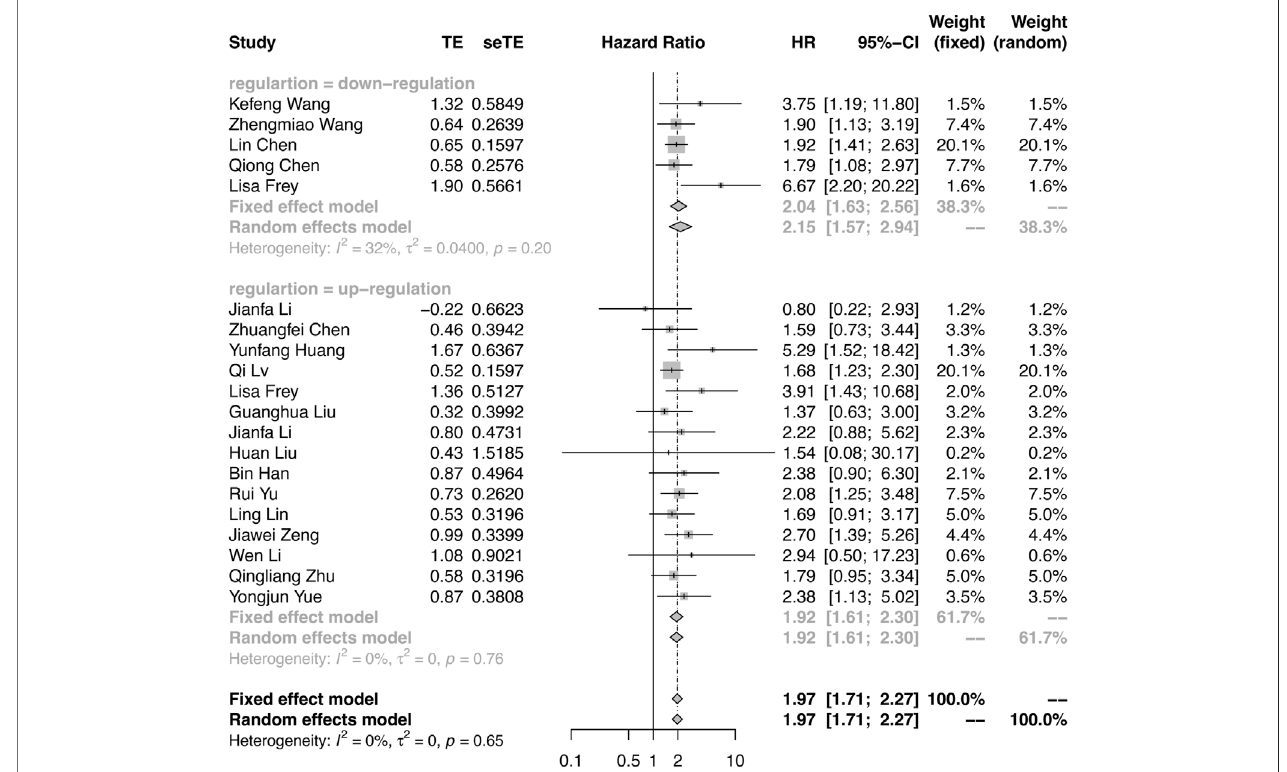
FIGURE 2 | Forest plots verify the association between the expression of circRNAs and overall survival (OS). High expression of oncogenic circRNAs and low expression of tumor-suppressor circRNAs were associated with poor OS.